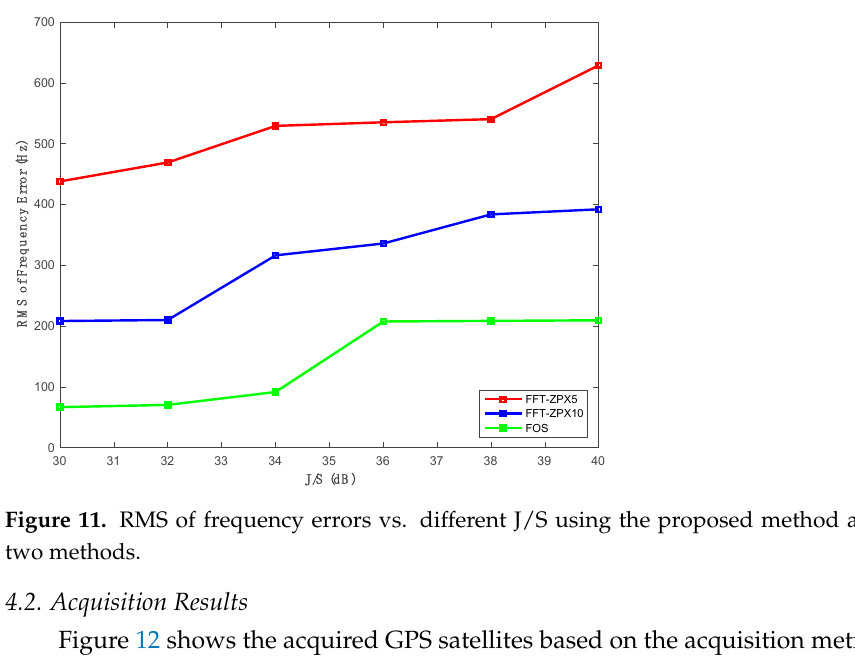
11 of 16 Figure 10. Estimated swept jamming signal frequency errors using the proposed method, FFT, and zero-padding FFT-based anti-jamming algorithms. To examine the proposed algorithm’s performance against different J/S ratios, the IF